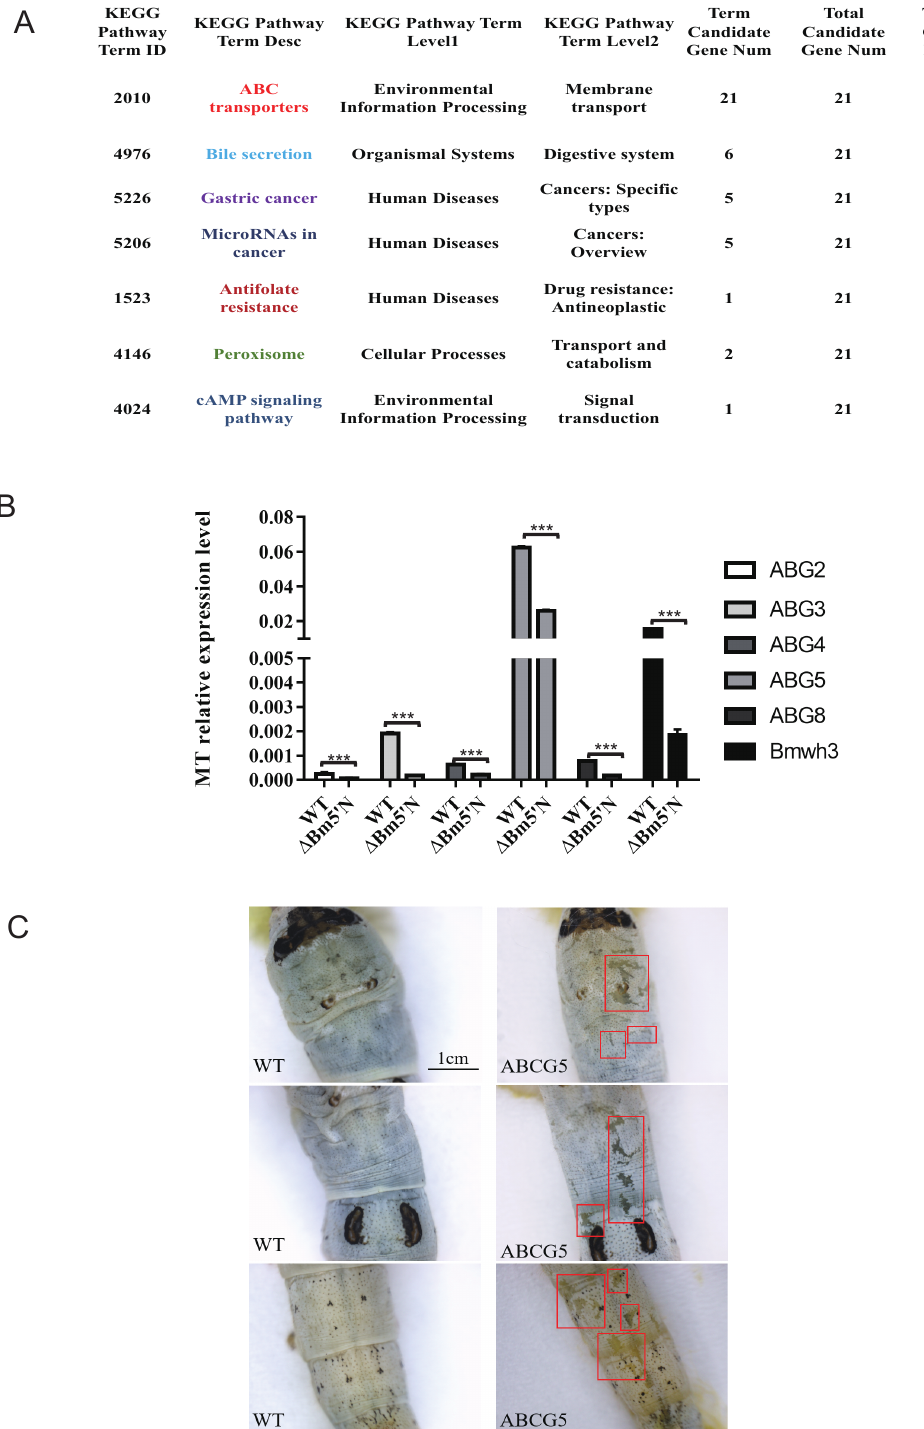
Figure 7. Transporter expression is disrupted in ∆ Bm5 (cid:48) N larvae. ( A ) Transporter genes differentially expressed in ∆ Bm5 (cid:48) N and WT larvae. ( B ) qRT-PCR analysis of ABC related gene’s mRNA expression in ∆ Bm5 (cid:48) N and WT at the fifth larval instar MT. ( C ) Enlargement of the translucent mosaic larval of ∆ BmABCG5 at the fifth instar. The red box indicated representative areas of the translucent integument. *** p <